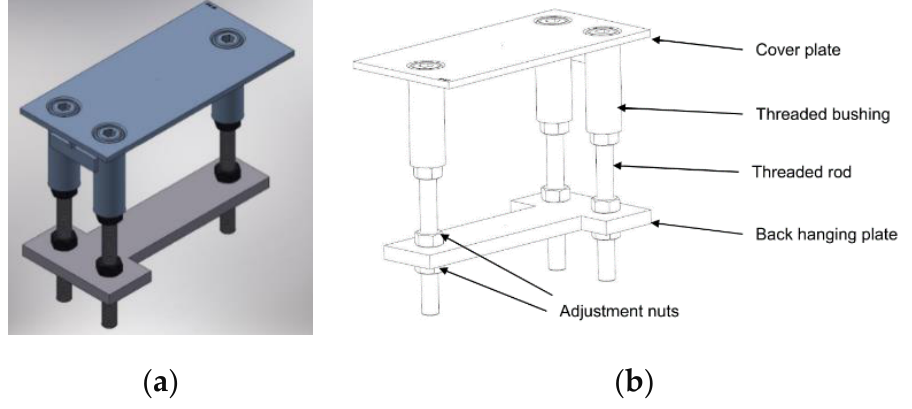
Figure 6. Anchor plate: ( a ) Anchor plate—BIM model, and ( b ) anchor plate—components.